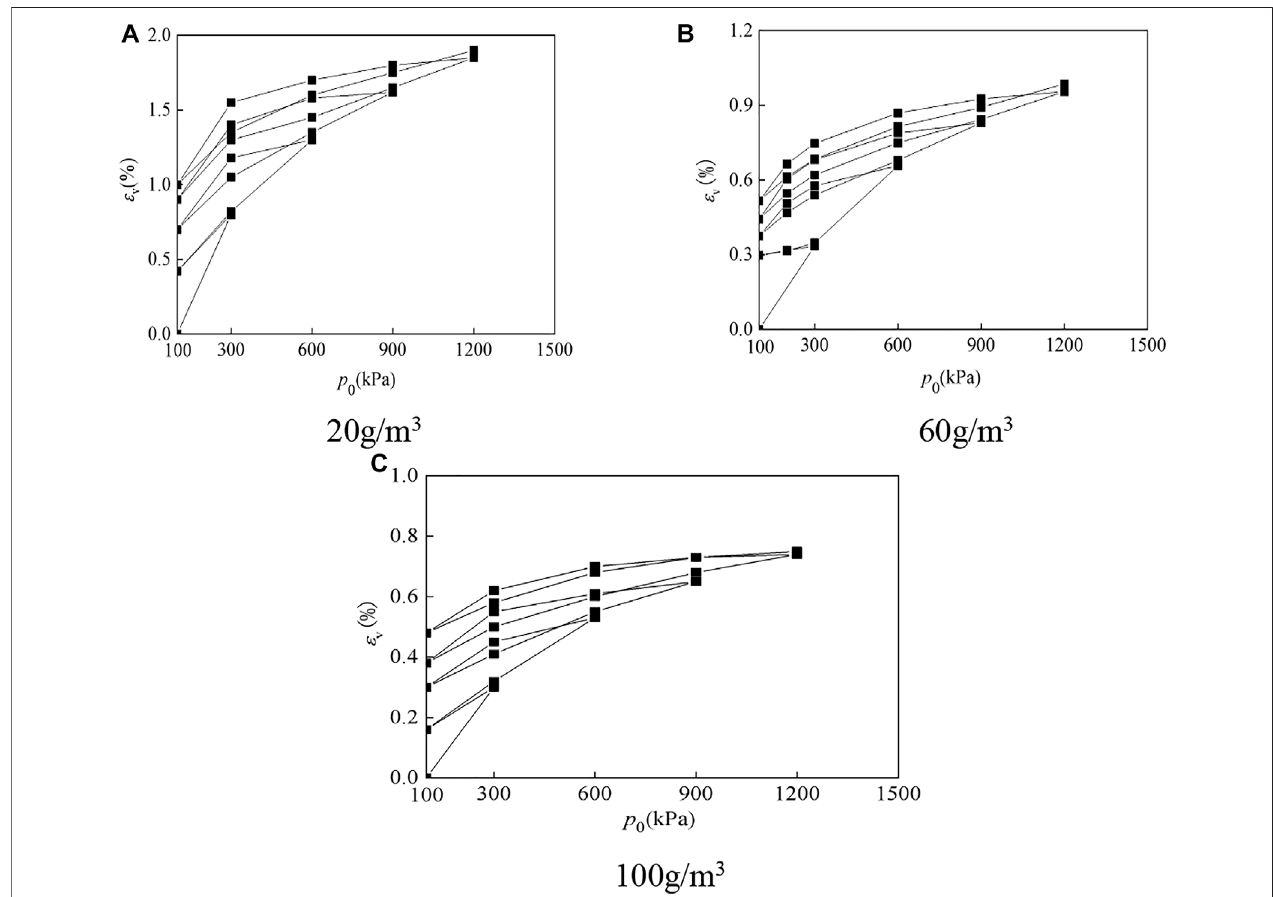
FIGURE 8 | The triaxial equiaxial loading and unloading test curves of LCSG material. (A) 20 g/m3 (B) 60 g/m3 (C) 100 g/m 3 .